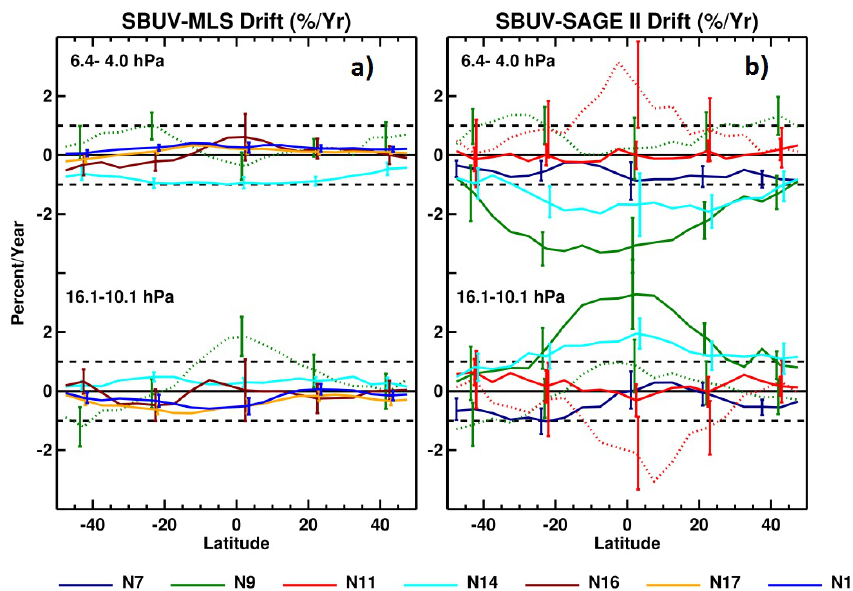
Fig. 12. Drifts (% per year) for individual SBUV instruments relative to independent satellite observations as a function of latitude for two layers: 16–10hPa and 6.4–4hPa. Colors correspond to individual SBUV instruments. Vertical bars indicate two times the standard deviation of the slope. Error bars were calculated for each 5 ◦ latitude bin but are shown only for 5 latitude bins: 40–45 ◦ S, 20–25 ◦ S, 0–5 ◦ N, 20– 25 ◦ N, 40–45 ◦ N. Error markers for different SBUV instruments are slightly shifted relative to each other. Drifts are estimated separately for ascending (solid lines) and descending (dotted lines) modes of N9, N11 and N14. (a) Drifts relative to Aura (2004–2011) and